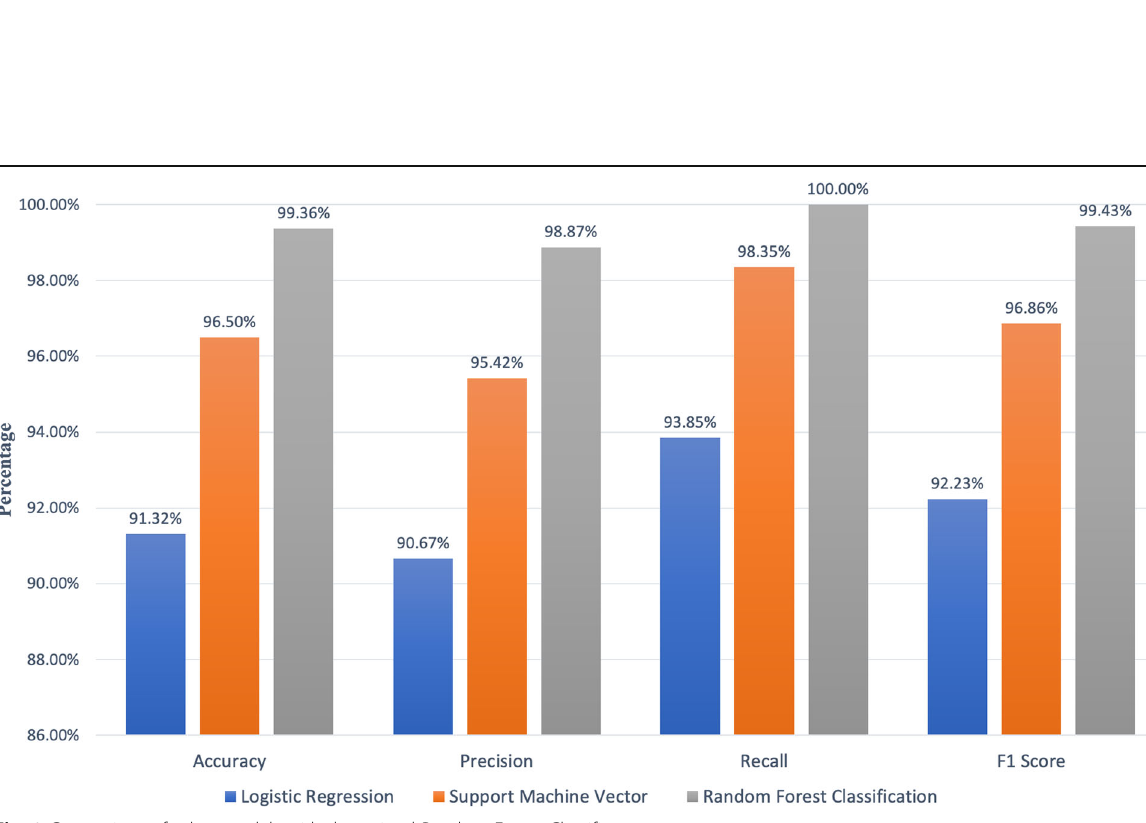
Fig. 9 Comparison of other models with the trained Random Forest Classifier